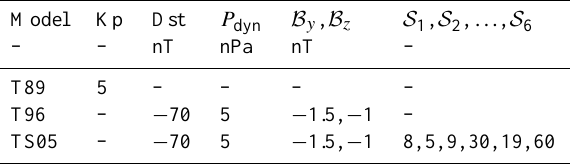
Table 1. Input to the Tsyganenko models T89, T96 and TS05 for the benchmark case computations presented in Fig. 2.